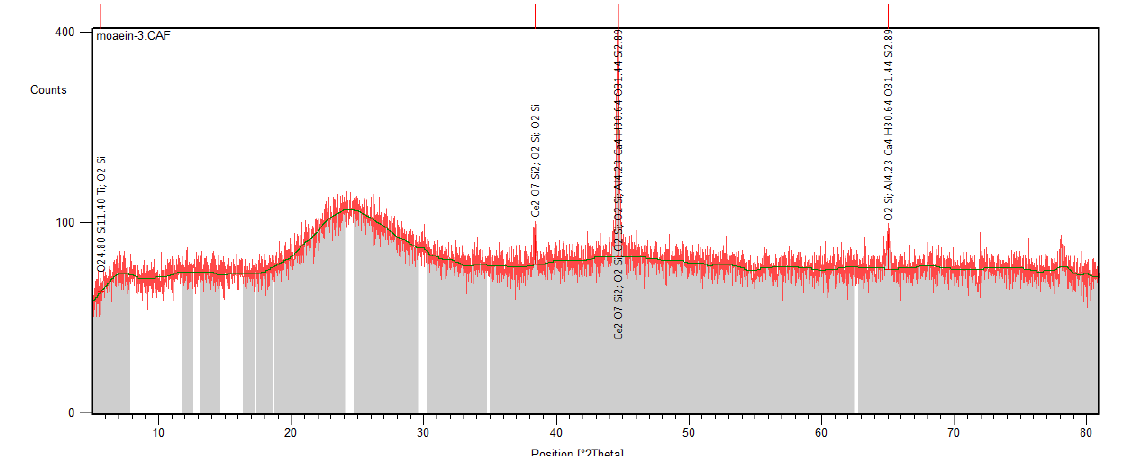
Figure 2. XRD of SiO